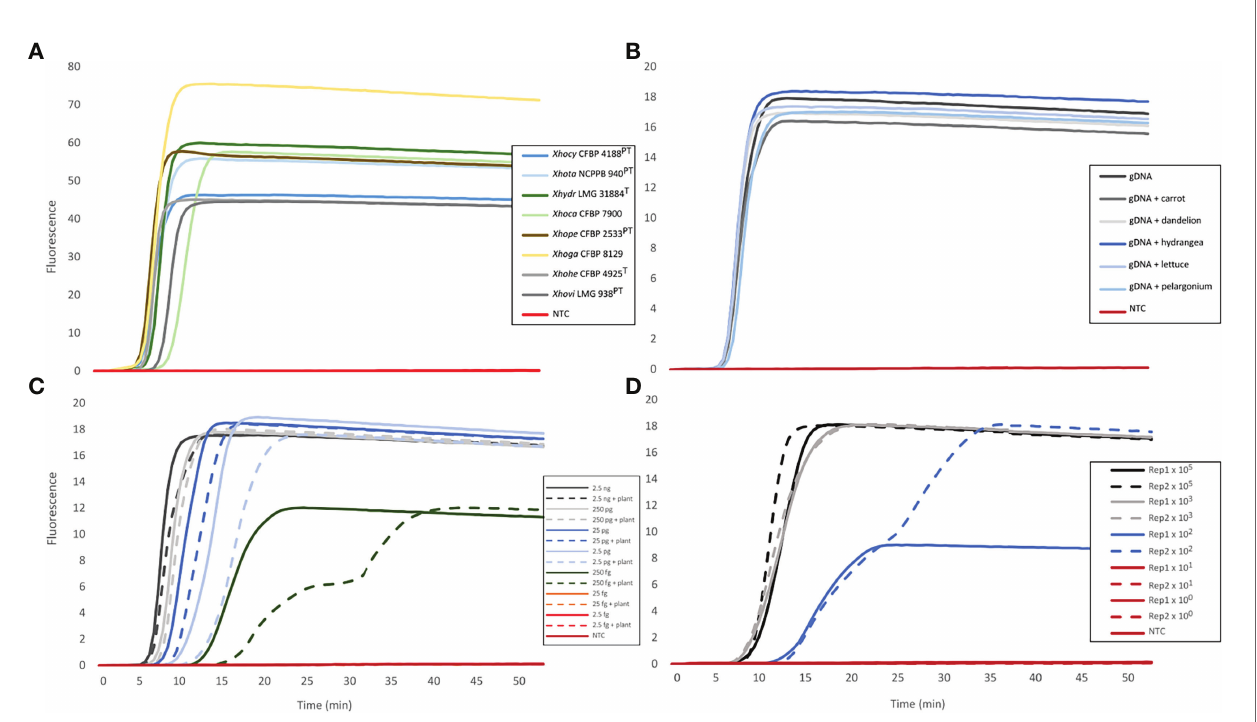
FIGURE 3 | Representative ampli fi cations of the assay targeting the Xanthomonas hortorum – Xanthomonas hydrangeae complex. The ampli fi cations were obtained with: (A) the genomic DNA of the eight reference strains for which abbreviations are as follows: X. hortorum pvs. cynarae ( Xhocy ), gardneri ( Xhoga ), taraxaci ( Xhota ), pelargonii ( Xhope ), carotae ( Xhoca ), vitians ( Xhovi ) and hederae ( Xhohe ), in addition to X. hydrangeae ( Xhydr ), (B) the spiked genomic DNA (gDNA) of X. hortorum pv. hederae strain CFBP 4925 T with non-host plant extracts (i.e., carrot, dandelion, hydrangea, lettuce or pelargonium), (C) a 10-fold genomic DNA dilution series of X. hortorum pv. hederae strain CFBP 4925 T , with and without ivy extract spiking, and (D) crude bacterial ( X. hortorum pv. hederae strain CFBP 4925 T ) and ivy mixture in two biological replicates (Rep1 and